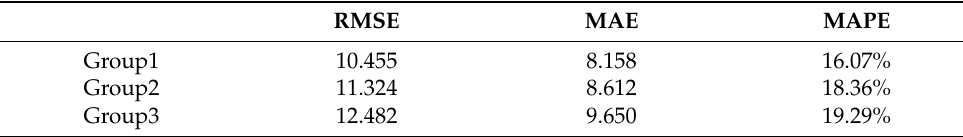
Table 9. Fitting degree of the training set of the time series model.